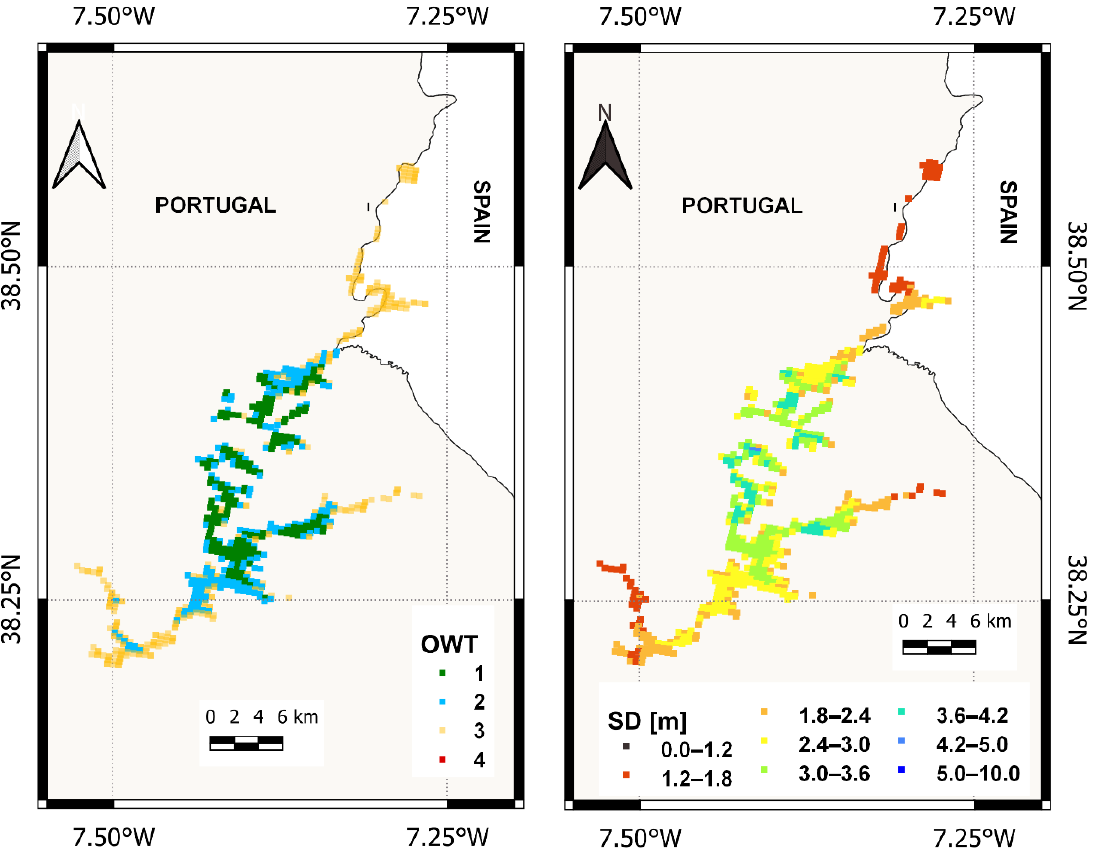
Figure 15. OWT ( left ) and Secchi depth ( right ) maps on 27 March 2018 in the Alqueva reservoir. During microalgae bloom events (July – October), there is also agreement between RGB images and water quality estimates (not shown here). Greenish colors in the RGB image (representing microalgae in water surface) correspond, in most cases, to the attrib- ution of OWT4 cluster and high concentrations of Chl-a, PC, and low SDs. As in the in- tense precipitation events, there are high spatial variations. In July, the northern region of the reservoir normally presents microalgae, with high Chl-a concentrations and OWT4 classification. However, the other areas of the reservoir usually do not have a relevant frequency of OWT4 attribution. An example in Figure 16 for 23 July 2017 shows a map of Chl-a concentrations and the OWT classification. Very low Chl-a concentrations are asso- ciated with OWT1 assignment. Low to intermediate Chl-a concentrations are associated with the OWT2 or OWT3 cluster. High or very high Chl-a concentrations appear on this day in the northern region of the Alqueva reservoir and are already associated with the OWT4 cluster. At the end of summer, in September 2017, the microalgae evolve towards the south, also occupying the entire central area of the reservoir. The OWT classification and maps of Chl-a, PC, and SD for 26 September 2017 are presented in Figure 17. The areas without the presence of algae are assigned to the OWT1 or OWT2 clusters, and also have the lowest water turbidity in these areas (highest SD). On this day, several areas are iden- tified with the presence of cyanobacteria blooms. There is agreement between the OWT classification (Cluster OWT4) with the estimates of Chl-a and PC (very high concentra- tions). These are therefore areas with a high probability of cyanobacteria presence.